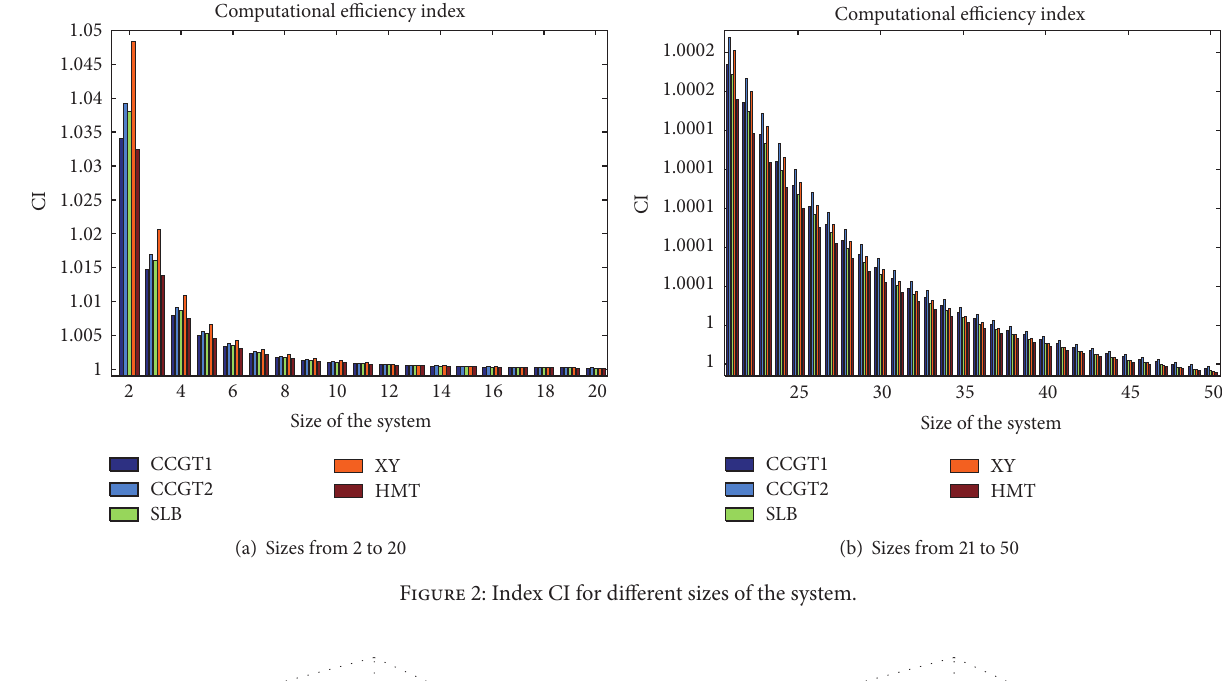
Figure 2: Index CI for different sizes of the system.